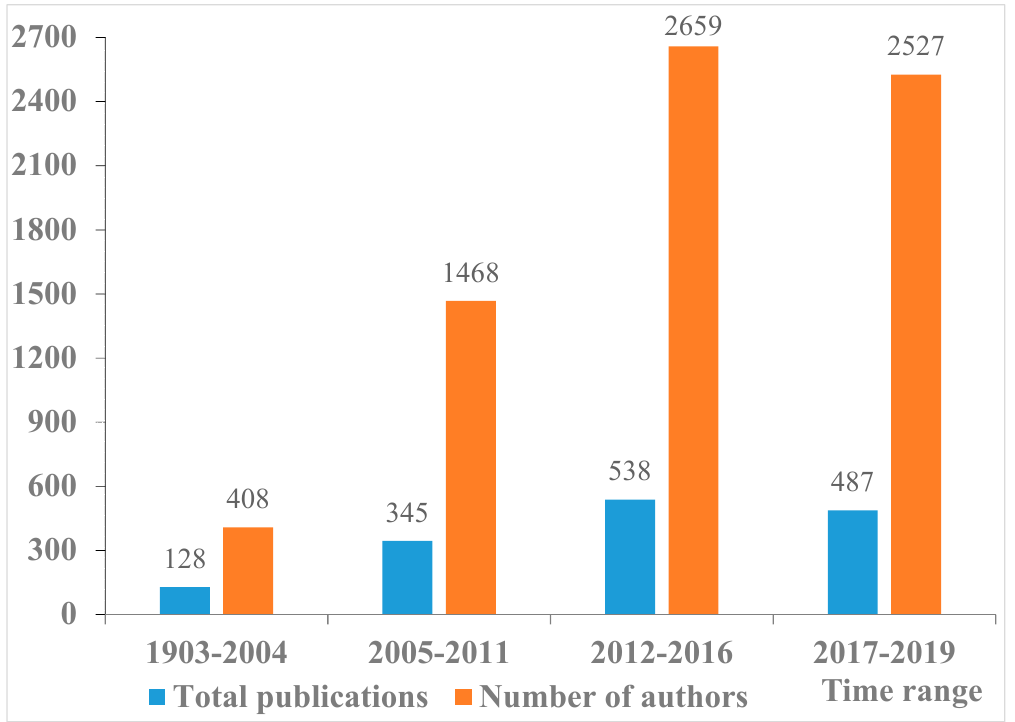
Figure 5. Number of total publications and the number of authors in the research of farmland abandonment in each time range.